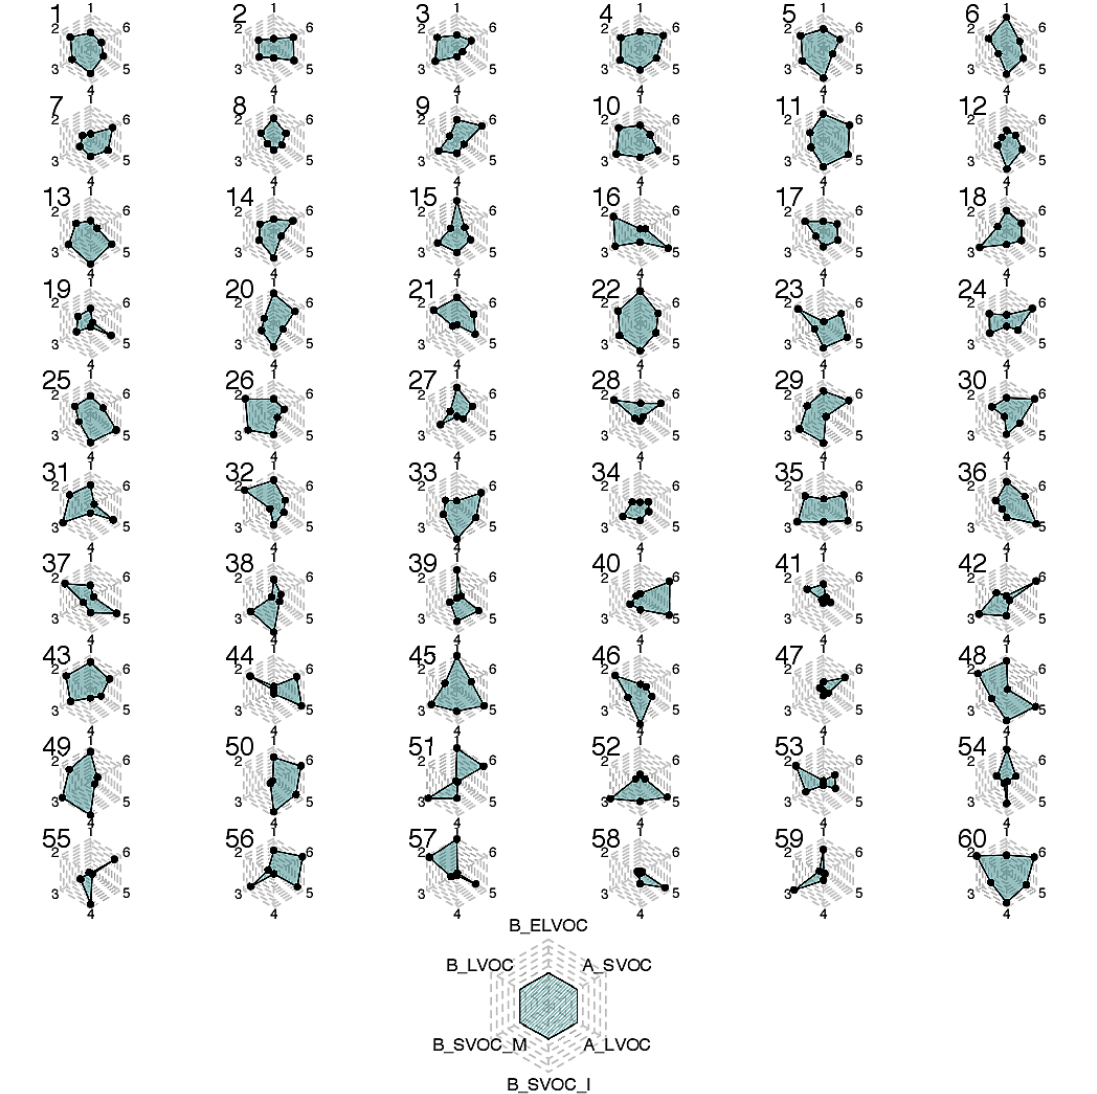
Figure 2. The relative variation in the six perturbed parameters (%) for each ensemble member (numbered 1 to 60). Each hexagon (grey dashed area) represents the 6-D parameter space and the positions of the black dots show the position of each parameter within its range for the specific ensemble member. The dots are joined and shaded green for easy identification of explored parameter space in each ensemble member. Anticlockwise from top, the black dots represent parameter settings for B_ELVOC, B_LVOC, B_SVOC_M, B_SVOC_I, A_LVOC, and A_SVOC respectively. Example interpretation: in simulation 19 (fourth row, first hexagon) B_SVOC_I and A_SVOC concentrations are towards the lower ends of the respective ranges being explored for each of them while concentrations of A_LVOC are towards the high end of the A_LVOC